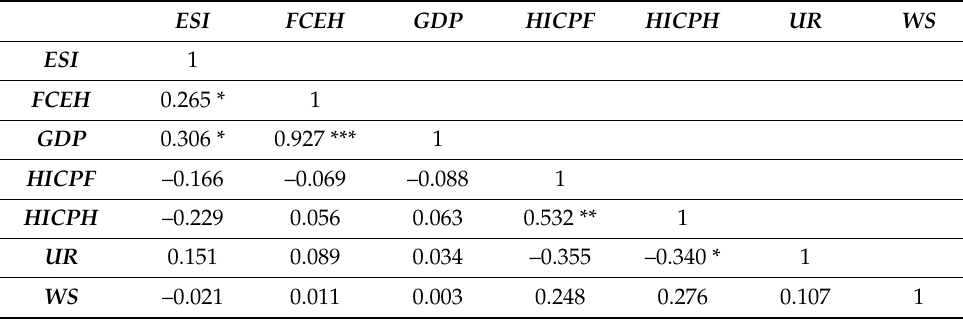
Table 2. Correlation matrix for the variables of interest.